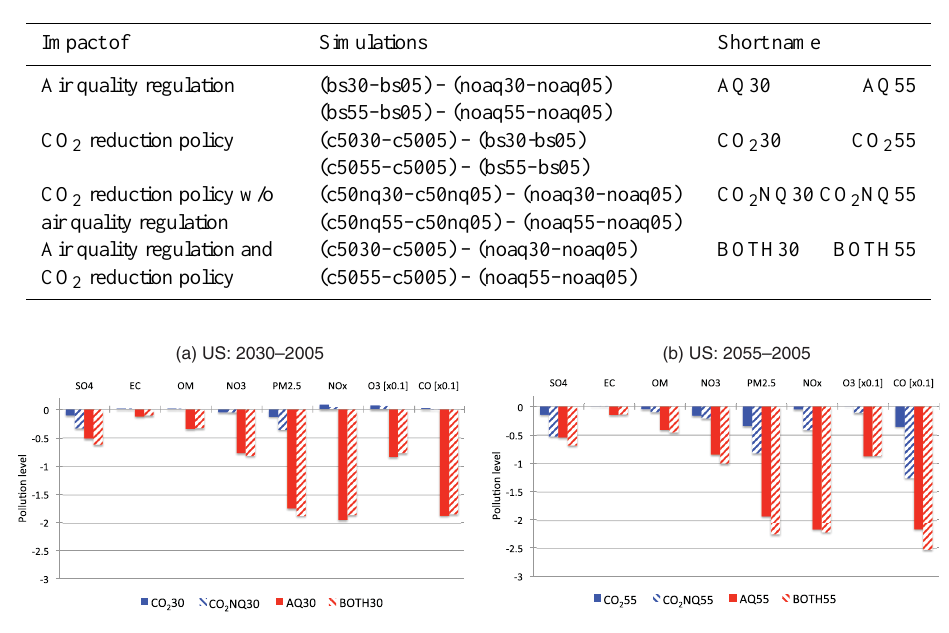
Table 3. Pair of the FIXMET simulations used to compute the impact of policies. In the Simulations column, the first letters represent the US emission scenarios and the last two numbers represent the emission year (bs for the baseline, noaq for the no air quality regulations, c50 for the 50% CO 2 cap in the baseline, and c50nq for the 50% CO 2 cap in the noaq scenario).